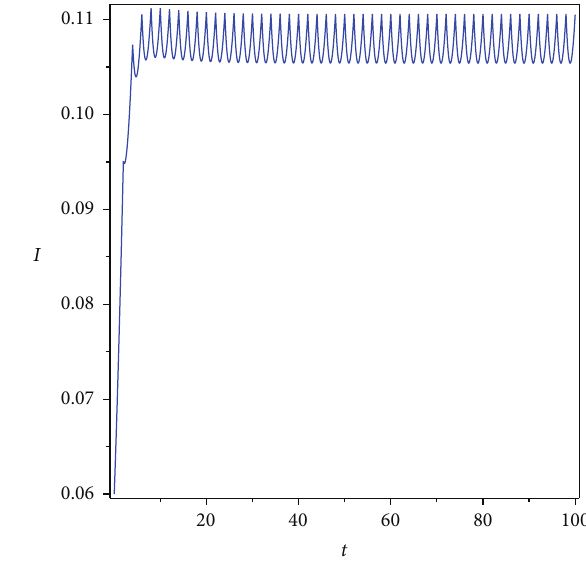
Figure 6: Time series of 𝐼 of system (42) while 𝜃 = 0.9 .